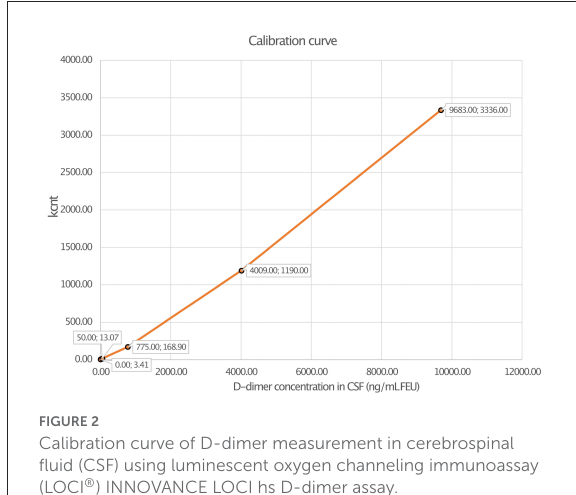
FIGURE1 Linearity curves of D-dimer in cerebrospinal fluid (CSF) measured with luminescent oxygen channeling immunoassay (LOCI ® ) INNOVANCE LOCI hs D-dimer assay.